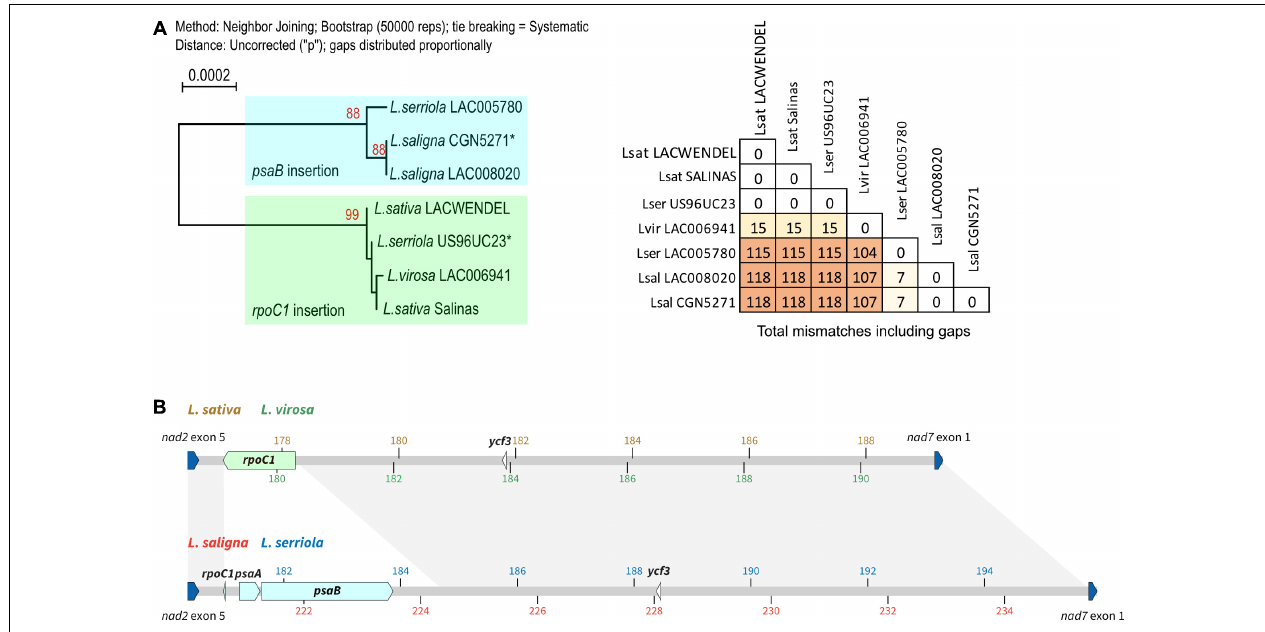
FIGURE 4 | Phylogeny of the mtDNA correlates with different plastidial DNA insertions. (A) Maximum likelihood phylogram based on the alignment of the concatenated protein coding sequences. Bootstrap values are indicated, as well as the table with the number of SNPs and gaps. Sequences labeled with an asterisk (*) are from Kozik et al. (2019). (B) The region between exon 5 of nad2 (last exon of the nad2b transcript) and exon 1 of nad7 (blue boxes) in the mtDNA of L. sativa, L. saligna, L. virosa , and L. serriola are represented with their plastidial DNA insertions (green boxes). Above is shown the context in L. sativa and L. virosa , with coordinates in brown and green, respectively. Below in L. serriola and L. saligna, with coordinates in blue and red,